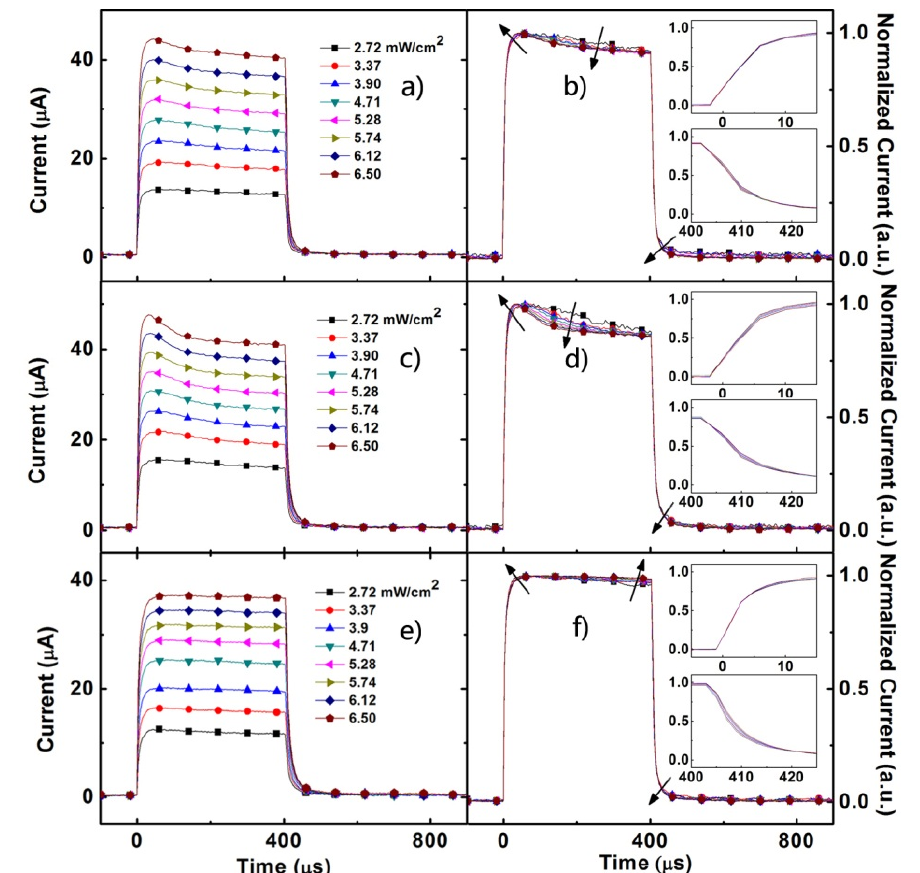
Figure 3. The normal (left) and normalized (right) transient short-circuit photocurrent of device A ( a , b ) device B ( c , d ) and device C ( e , f ) under illumination of 380 nm pulse with various intensities. The insets ( b , d , f ) show the detail of rise/fall